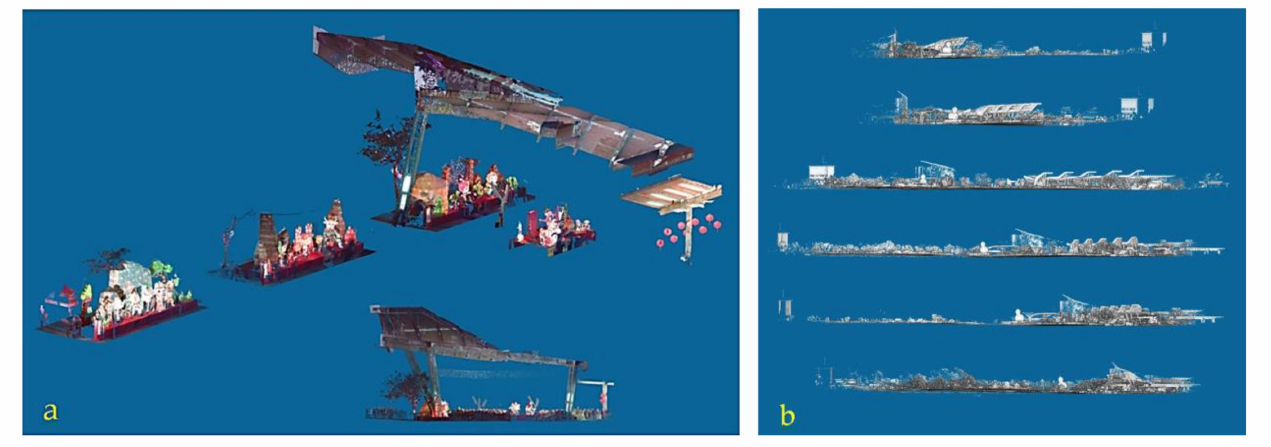
Figure 10. Two axes of lantern models ( a ) and many possible combinations perceived by visitors from different orientations ( b ).